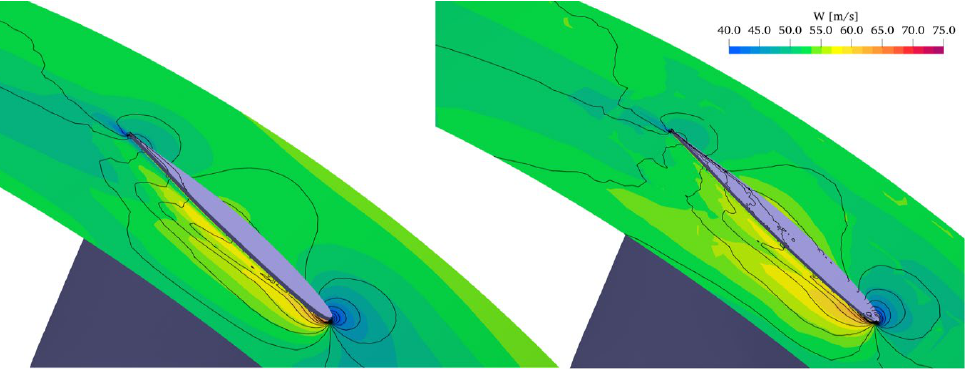
Figure 10. Relative velocity contours on iso-radius surface at 99% of the blade span. Left: datum; right: whaled.